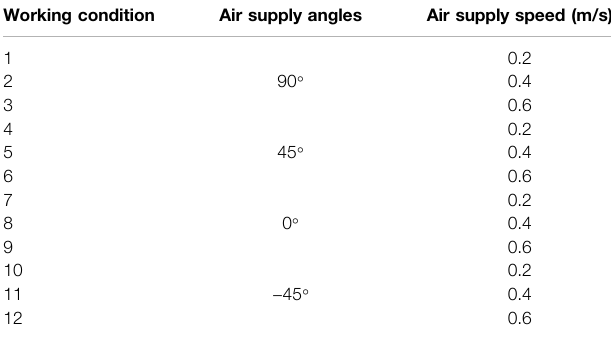
TABLE 2 | Related parameters of simulated working conditions. Working condition